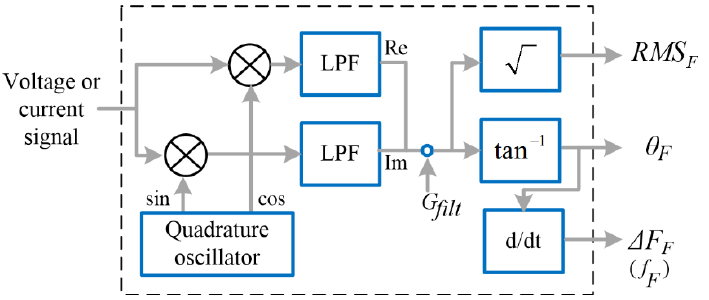
Figure 1. Reference signal processing model.